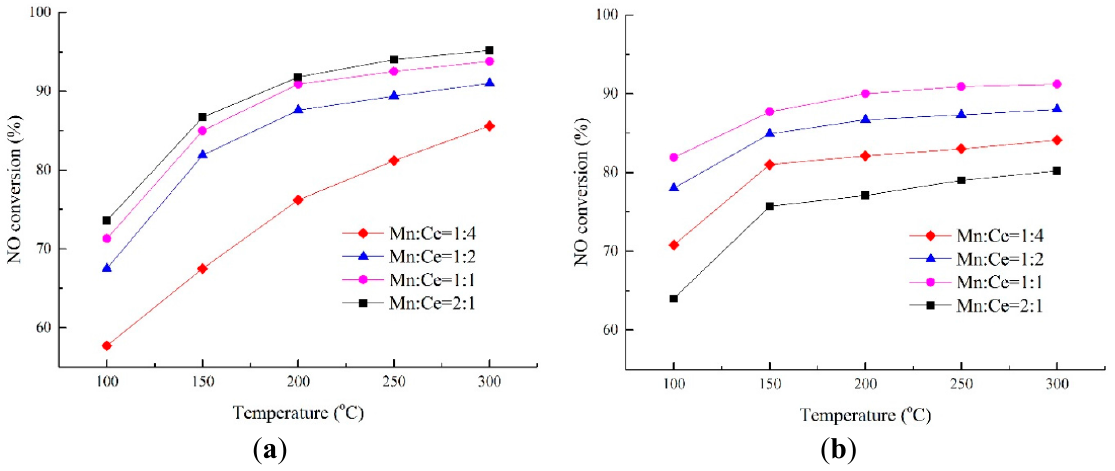
Figure 4. NH 3 -SCR using different 7% Mn-Ce/AC catalysts under ( a ) CO 2 and ( b ) N 2 atmosphere. Other conditions: 800 ppm NO; 800 ppm NH 3 ; 6% O 2 and space velocity 3408 h − 1 . With the increase of Mn:Ce ratio, the NO conversion was increased for the CO 2 atmosphere, and fluctuated (increased first and then decreased) for the N 2 atmosphere. For example, the NO conversion was around 73% for the CO 2 and only 64% for the N 2 in the presence of the 7% Mn-Ce/AC (Mn:Ce = 2:1) catalyst at 100 ˝ C. In addition, the overall performance of SCR was better in the CO 2 atmosphere compared with the N 2 atmosphere, when the catalyst has higher Mn:Ce